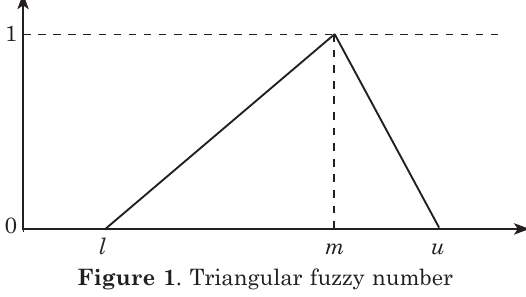
figure 1 . Triangular fuzzy